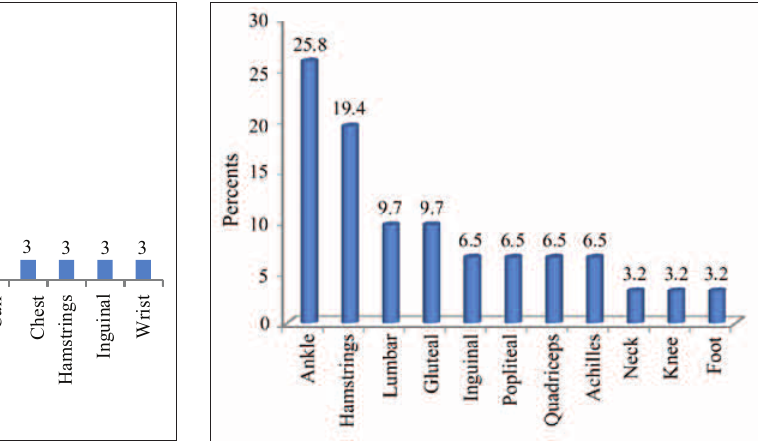
Figure 5. Injuries in thrower cohort Figure 6. Injuries in sprinter